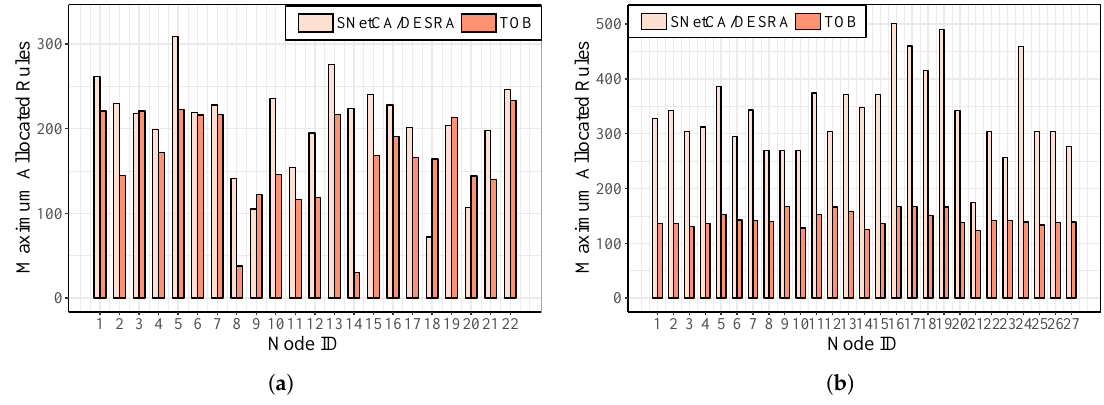
Figure 13. Average TCAM occupation with | C | = 2 in the: ( a ) Geant topology; and ( b ) Norway